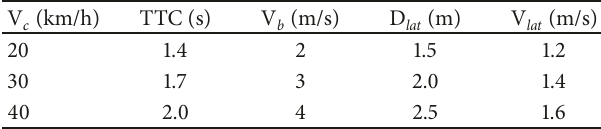
Table 1: Three-level parameters of different motion patterns.